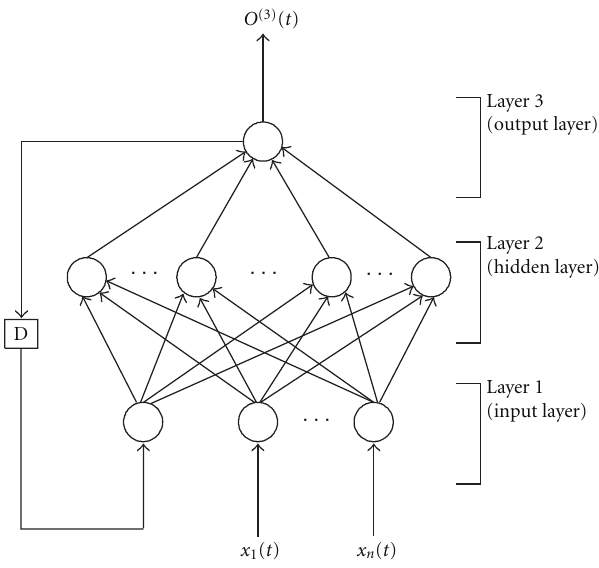
Figure 1: Structure of the